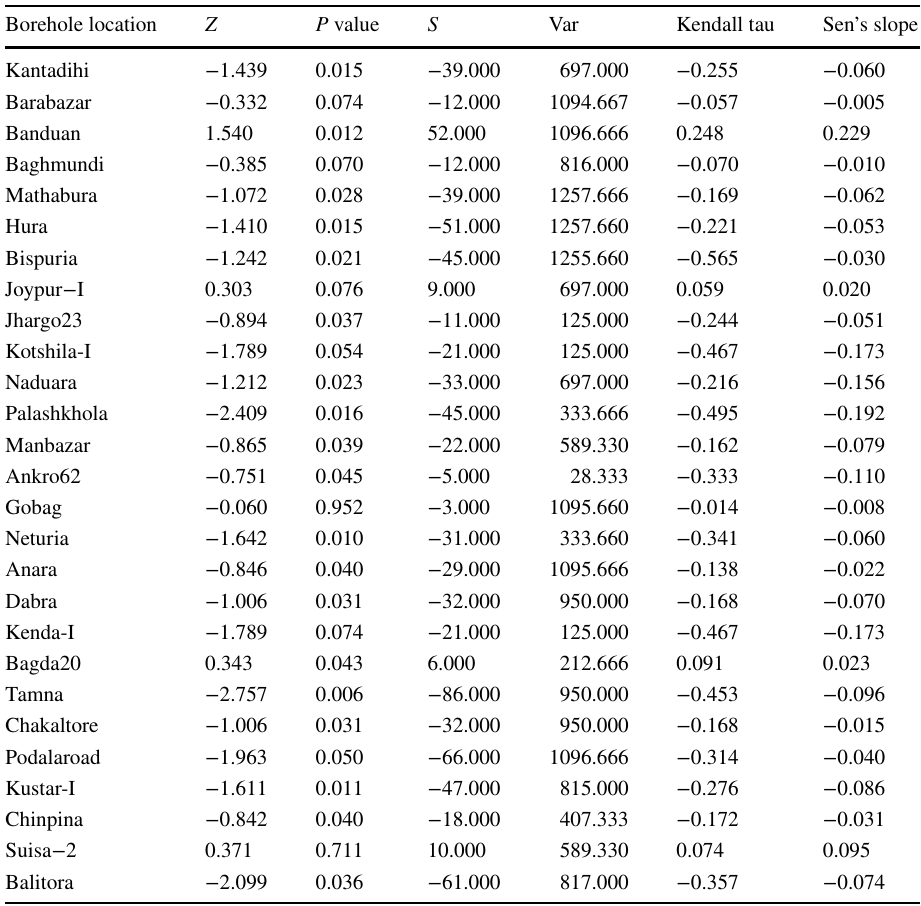
Kendall trend test on post- monsoon groundwater